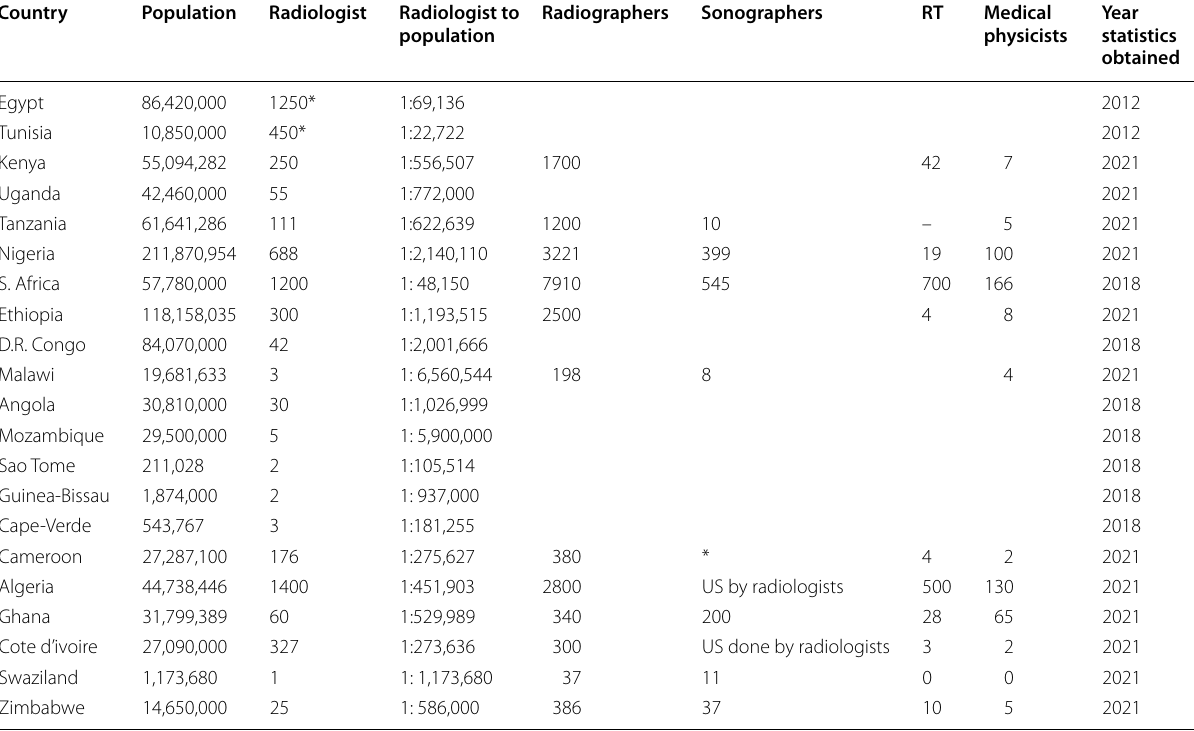
Table 3 Numbers of imaging personnel for selected African countries Country Population